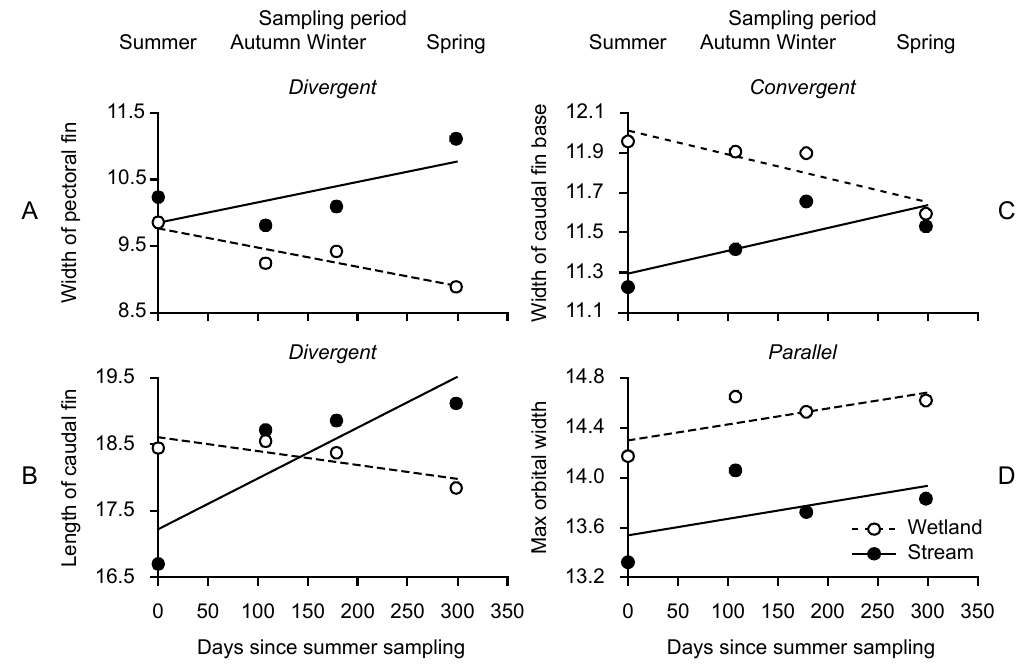
Figure 3. Developmental trajectories of wetland and stream field G. gollumoides . Plots show the three general patterns of developmental trajectories: ( A , B )—divergent; ( C )—convergent; and ( D )—parallel; based on seasonally measured mean standard length standardised morphological variables and linear trend lines.